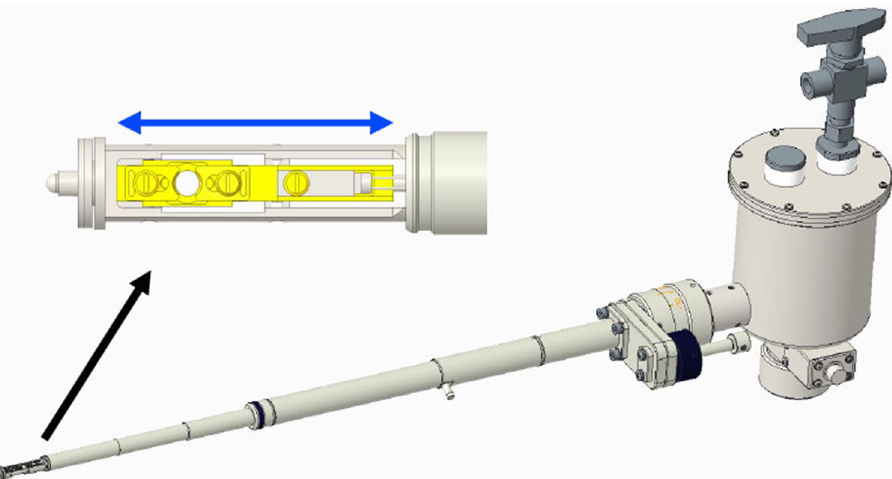
Figure 2. Schematic of the cryo-transfer holder. The inset shows an enlarged view of the specimen stage at the tip. The stage slides into the arm to prevent frost formation during transfer into the specimen chamber of the cryo-TSEM.